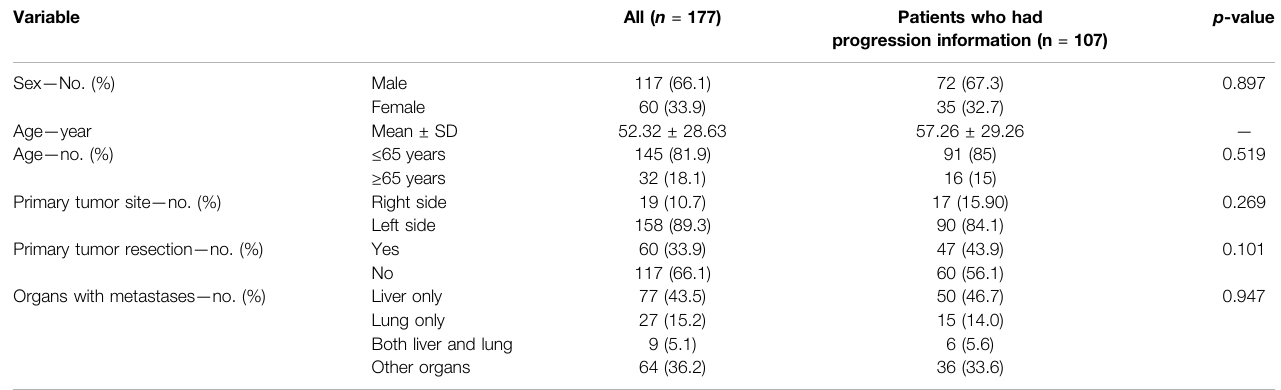
TABLE 1 | Baseline characteristics of the metastatic colorectal cancer patients.